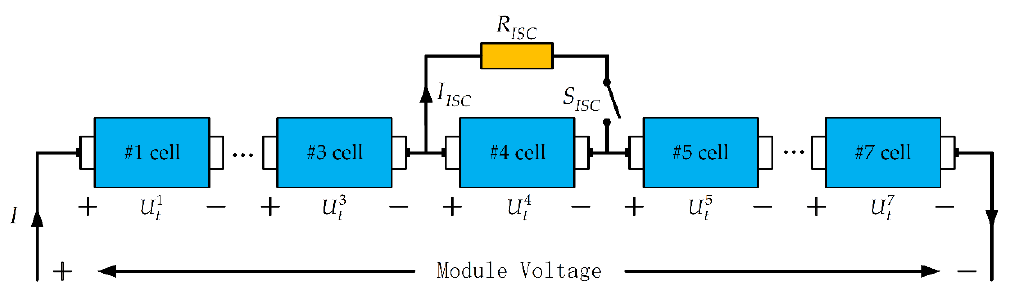
Figure 4. Scheme of the ER approach for the equivalent ISC test.